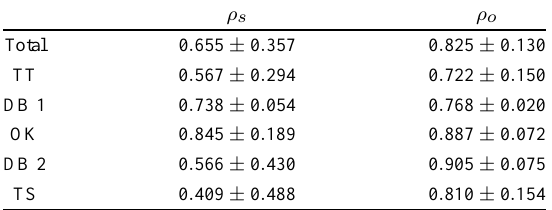
Statistical values of the coefficients ρ s and ρ o on the 14 smears for the different smear zones: too thick (TT), doubtful in the border be- tween TT and OK (DB 1), working area (OK), doubtful in the border between OK and TS (DB 2), and too spread (TS). Data are expressed as mean ± std . dev